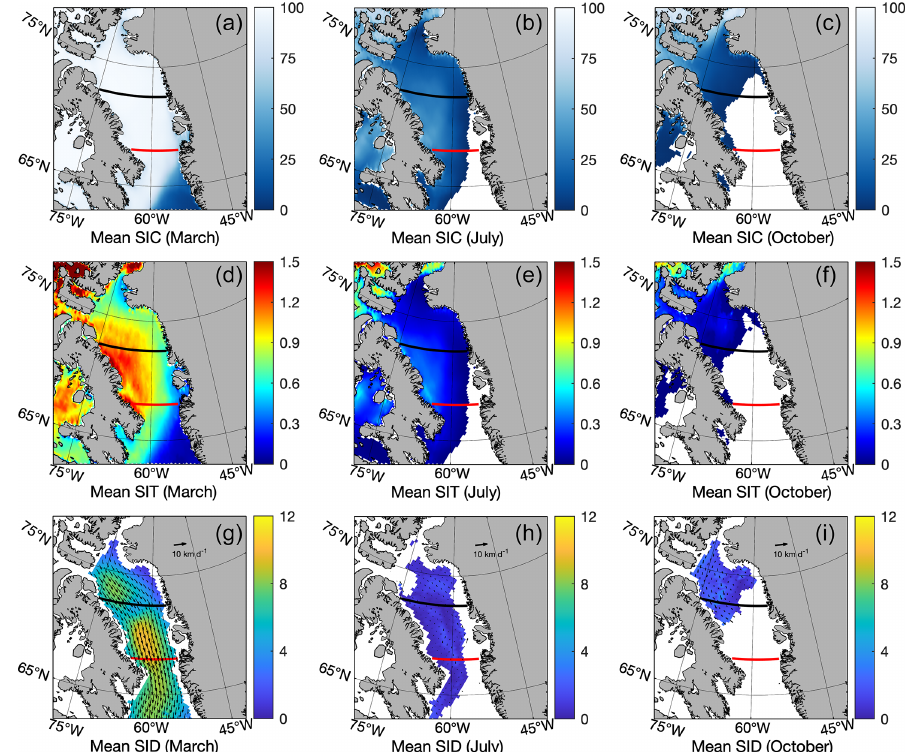
Figure 1. The ensemble mean sea-ice concentration ( a, b, c : SIC, unit: %) and thickness ( d, e, f : SIT, unit: m) in March, July and October averaged from CMST, NAOSIM, PIOMAS and Sat-merged SIT over the period 2011–2016. Sea-ice drift ( g, h, i : SID, unit: kmd − 1 ) is calculated by averaging data from NSIDC. Note that the Sat-merged SIT in the ensemble are only valid in March and October. The black line shows the SIV inflow gate, and the red line denotes the SIV outflow gate in the Baffin